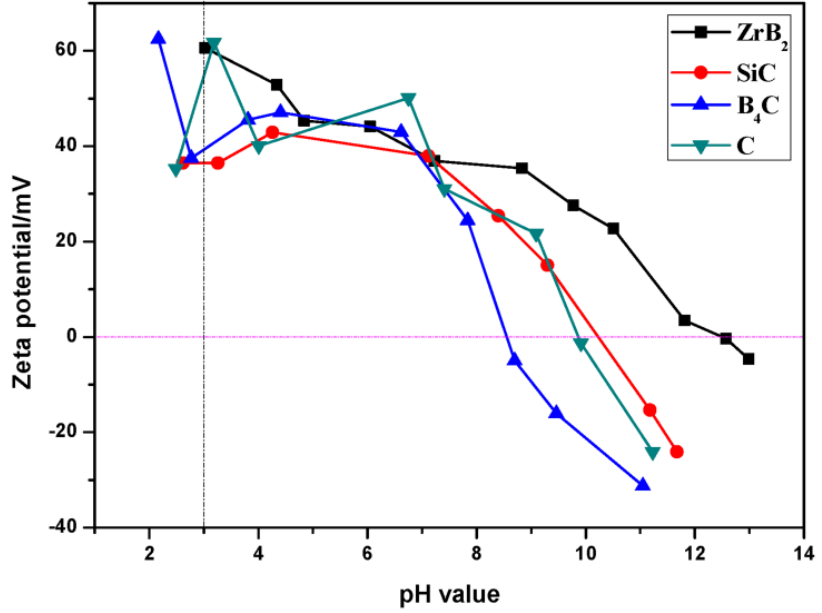
, SiC, B C, and C suspensions in the presence of 2 4